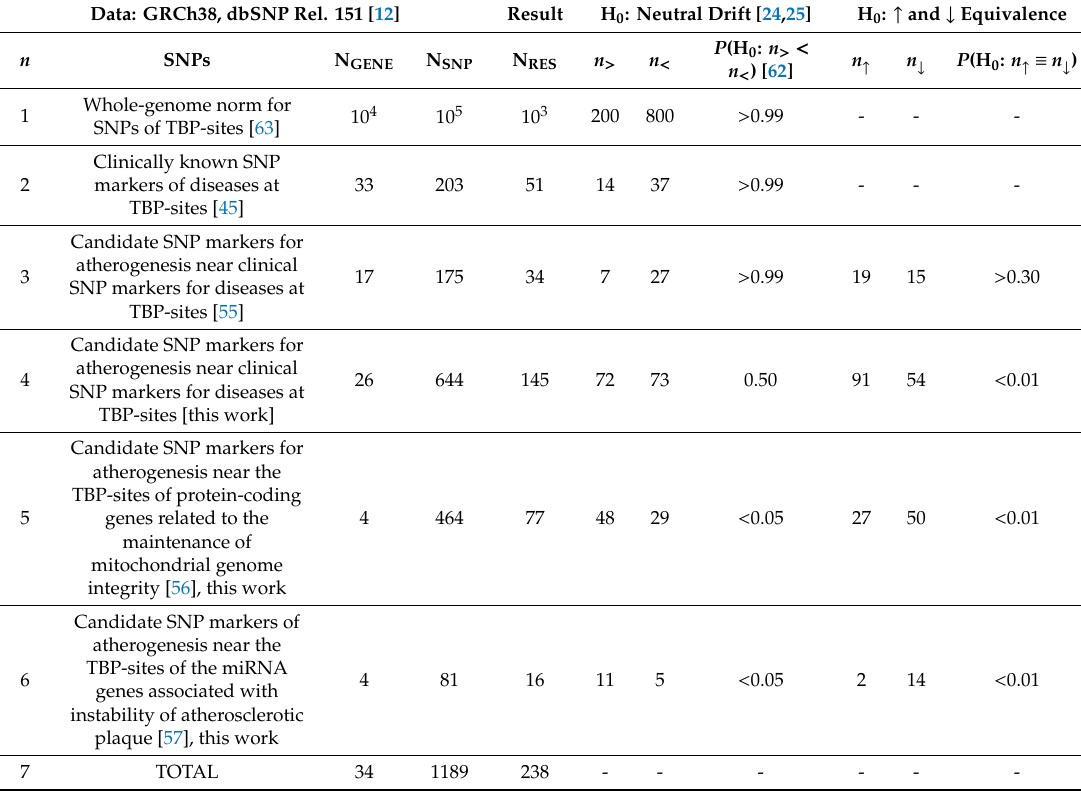
Table 1. Atherogenesis-related candidate SNP markers within the gene promoters, where SNPs of TBP-sitesareclinicallylinkedwiththehumandiseases;